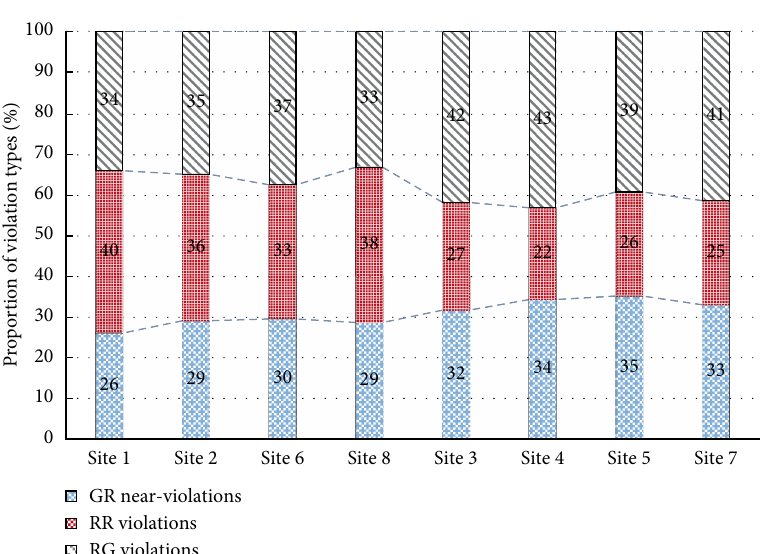
Figure 5: Proportion of violation types for each